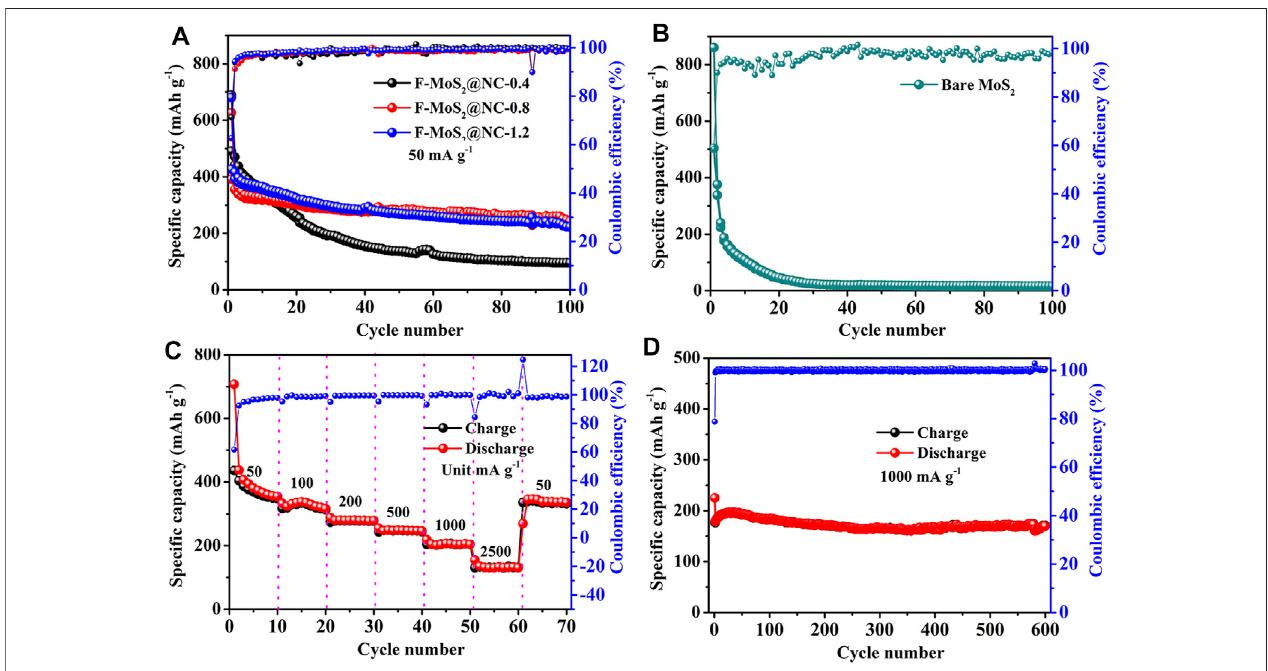
FIGURE9| ElectrochemicalperformanceofF-MoS 2 @NCasanodeofSIBs: (A) CycleperformancesofF-MoS 2 @NC-0.4,F-MoS 2 @NC-0.8,F-MoS 2 @NC-1.2and (B) bare MoS 2 at a current density of 50 mA g − 1 . (C) Rate performance of F-MoS 2 @NC-0.8 electrode. (D) Long cycling life of F-MoS 2 @NC-0.8 electrode at 1,000 mA g − 1